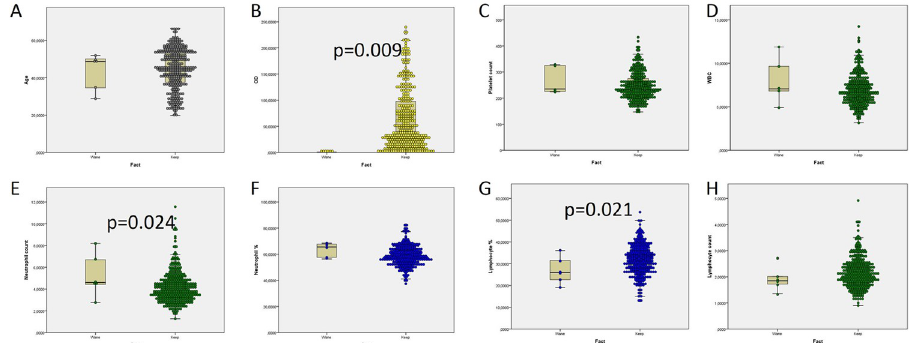
Fig 2. Analysis of age and haemogram. Comparison of age, OD from total immunoglobulins recognizing anti SARS-CoV-2 N protein, and haemogram in donations from antibody-keeping and antibody-waning donors. Wane: A positive donor becomes negative. OD: Optical